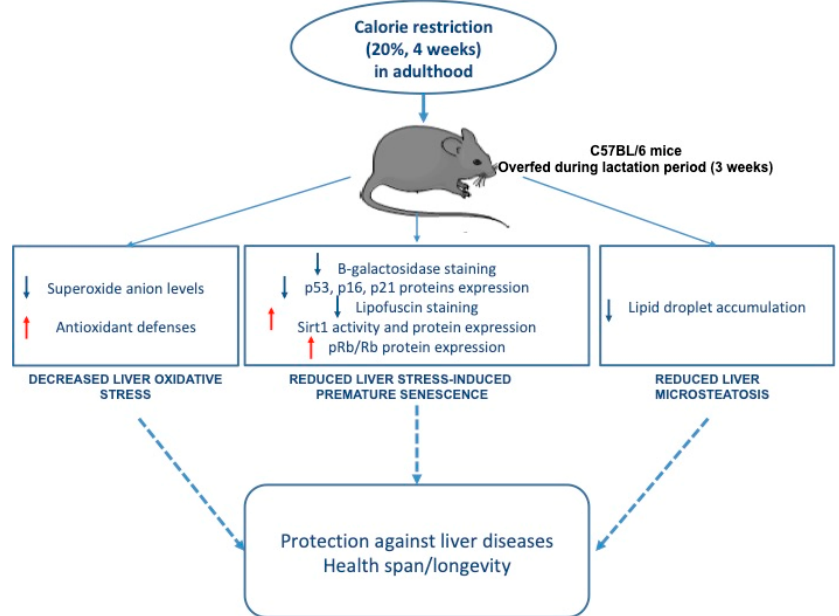
Figure 7. The e ff ects of moderate calorie restriction in adulthood on liver dysfunction induced by transient postnatal overfeeding in C57BL / 6